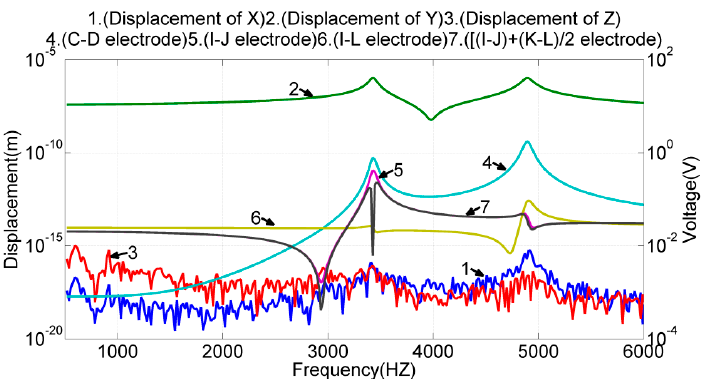
Figure 9. Frequency response of both the proof mass displacement and the voltage output of the sense electrodes when the device was actuated by the drive electrode pair ( A , B ).